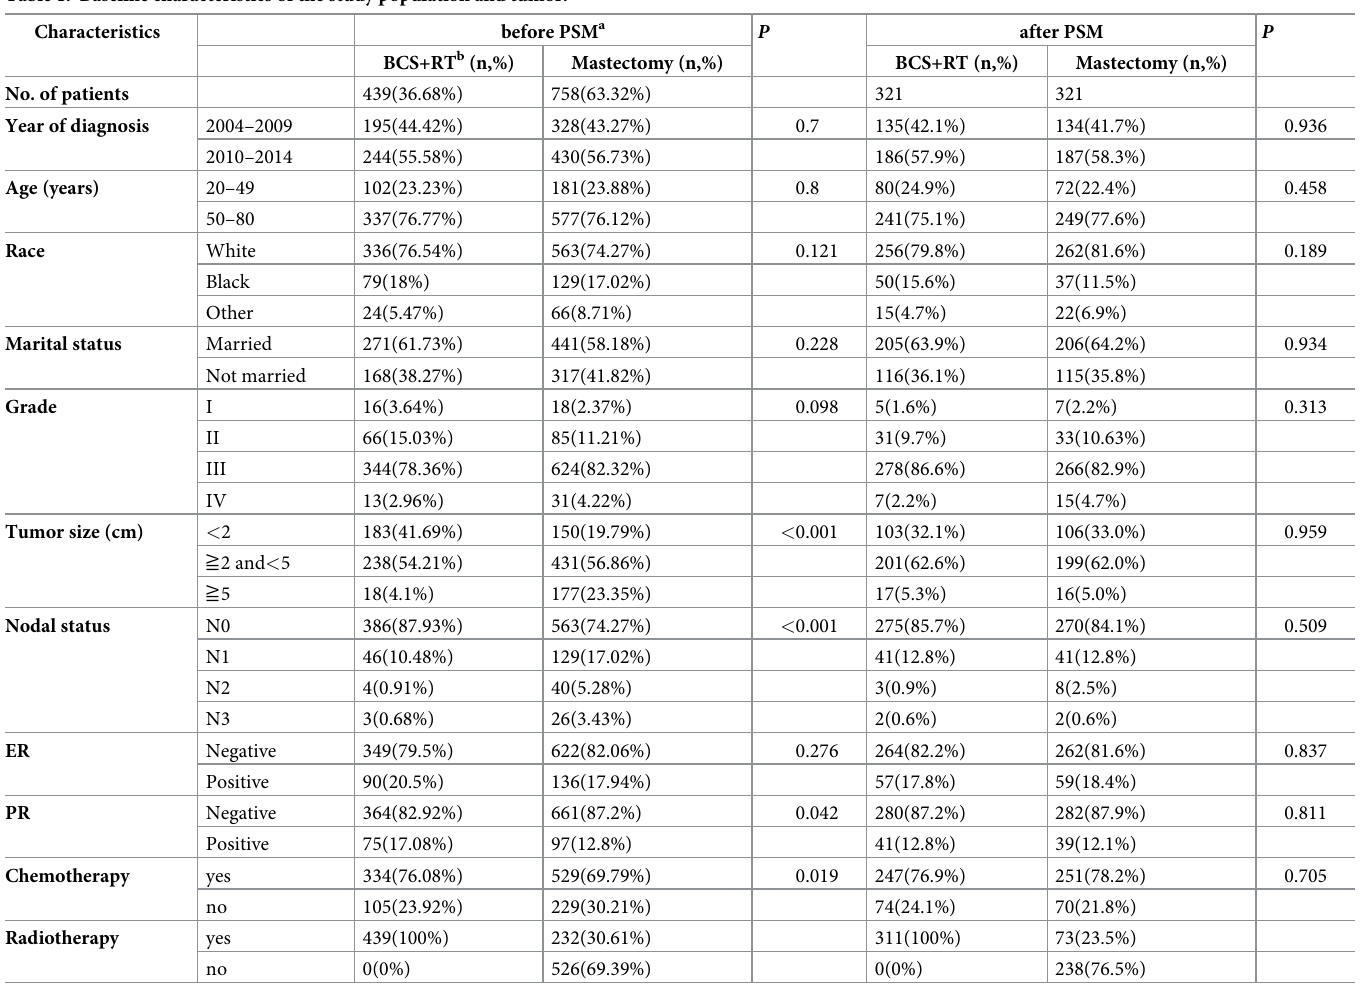
Table 1. Baseline characteristics of the study population and